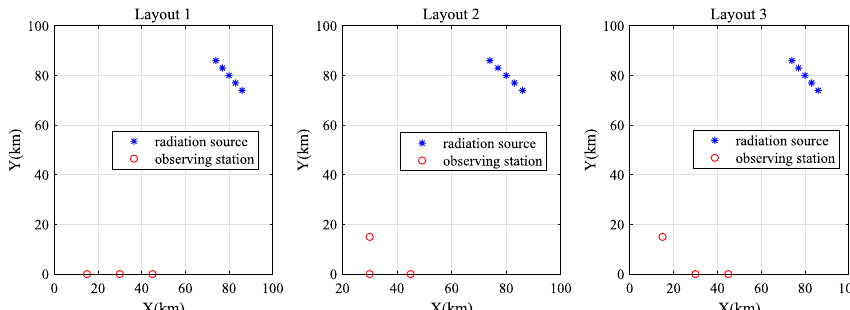
Fig. 11 Distribution of observation stations in three ways